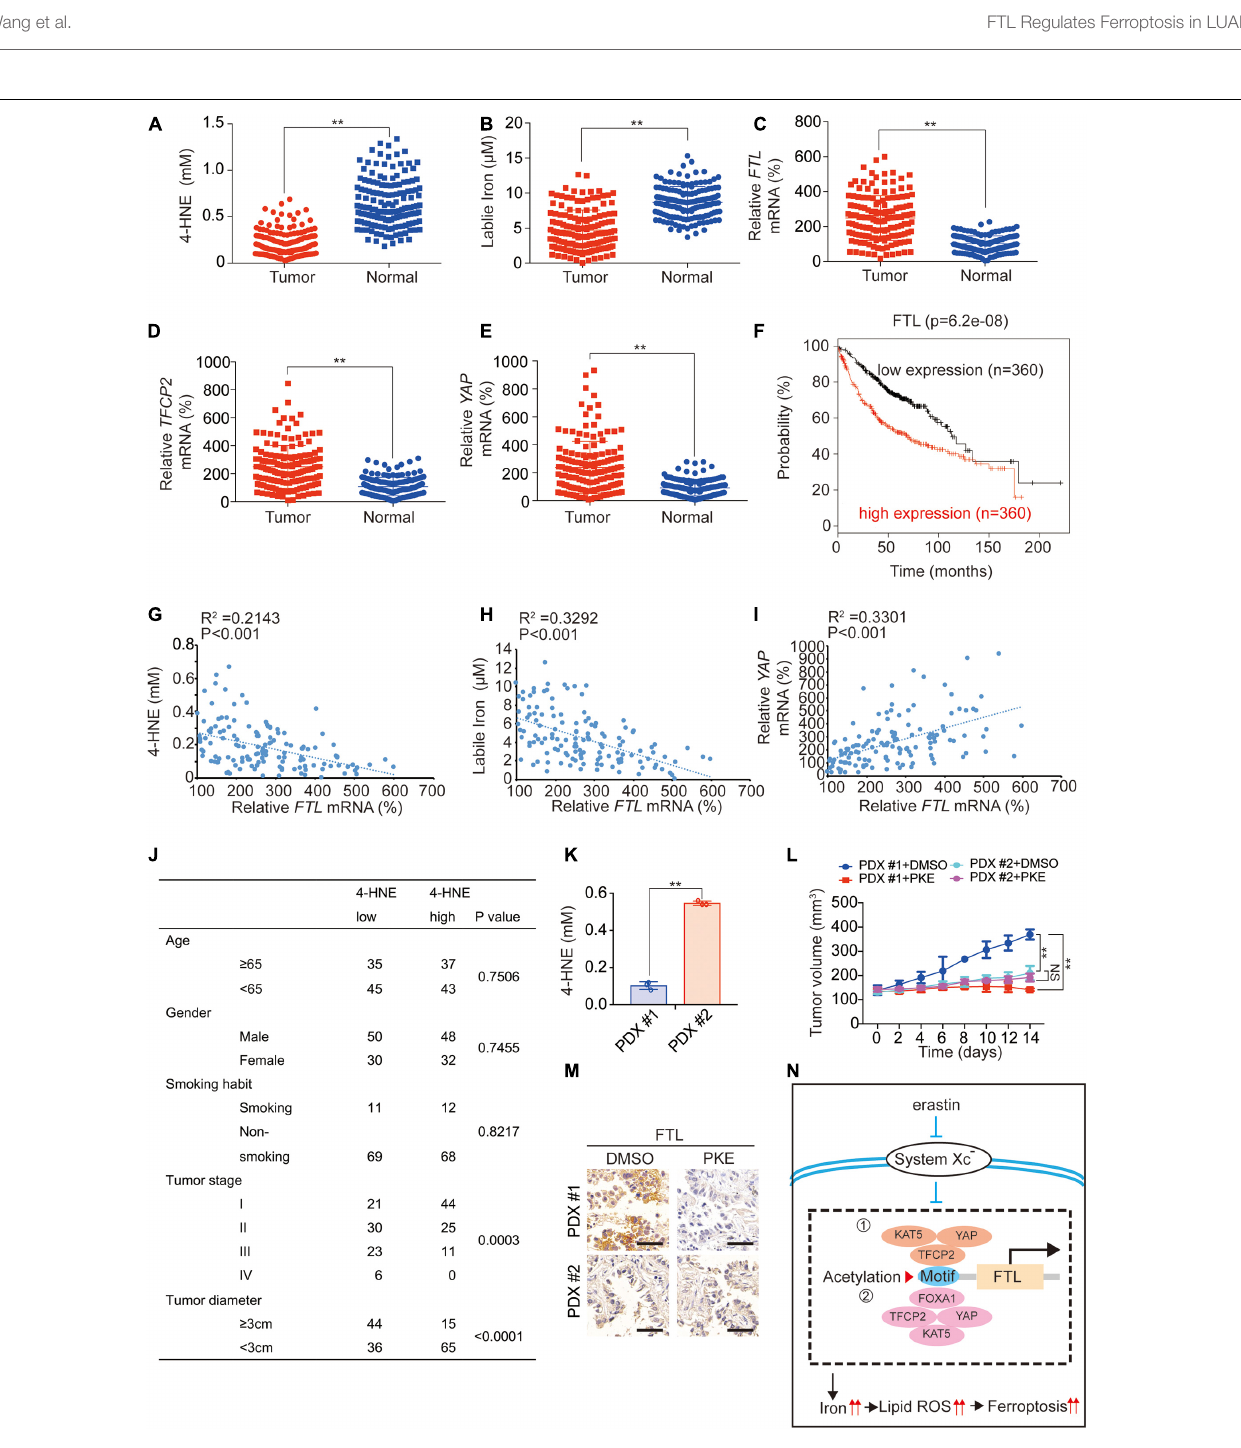
Frontiers in Cell and Developmental Biology |